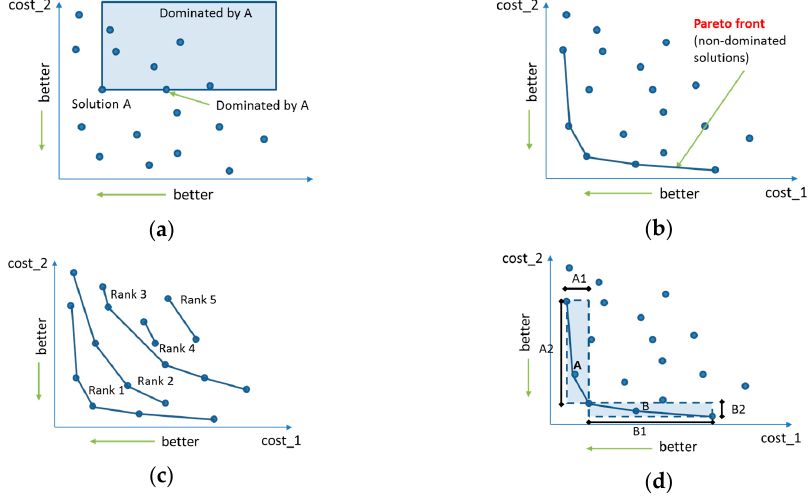
Figure 3. Definition of ( a ) dominance criterion, ( b ) Pareto front, ( c ) ranking of Pareto fronts, and ( d ) Manhattan distance for a two-objective minimization problem. and ( d ) Manhattan distance for a two-objective minimization